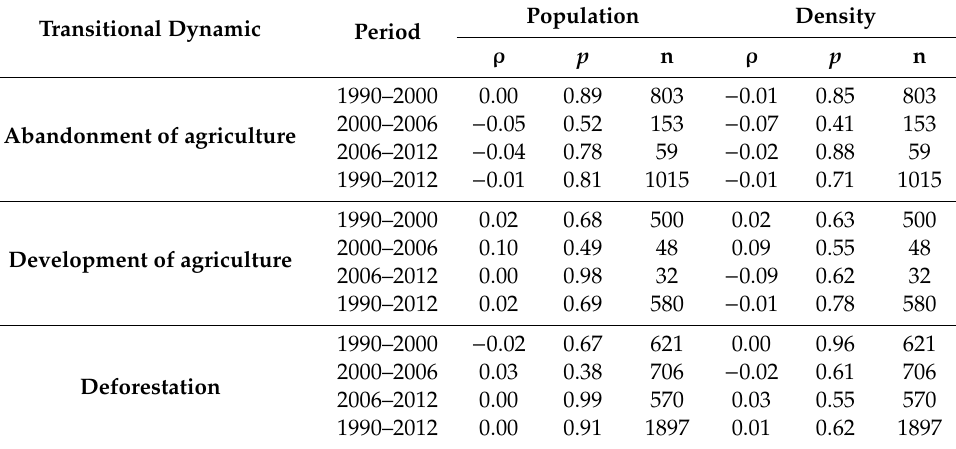
Table 2. Correlations between the area a ff ected by each transitional dynamic and population, respectively density change per each Romanian administrative unit within each period covered by CORINE data and overall. The table displays the values of the Bravais–Pearson coe ffi cient of linear correlation ( ρ ), its associated p -value ( p ) and sample size (n). Bold Italic values are significant at α = 0.05 and bold values marginally significant (0.05 < p ≤ 0.1). Dark shading indicates statistical significance or marginal